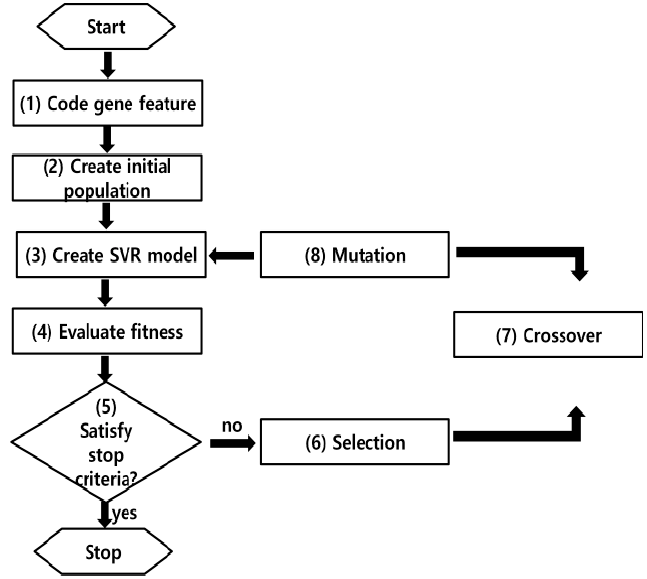
Figure 3. Process to deduce three parameters ( C, ε , r ) in Support Vector Machine